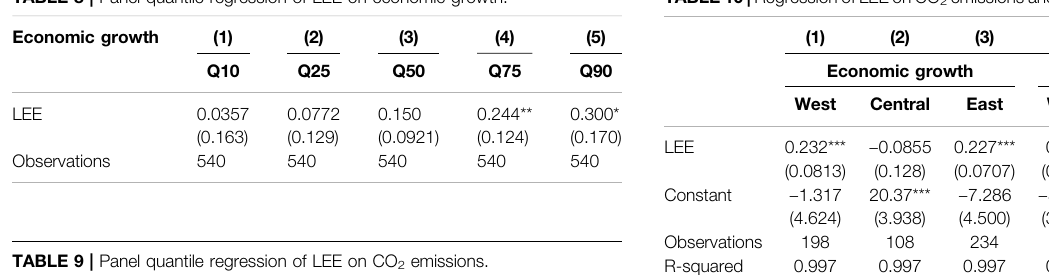
TABLE 8 | Panel quantile regression of LEE on economic growth.